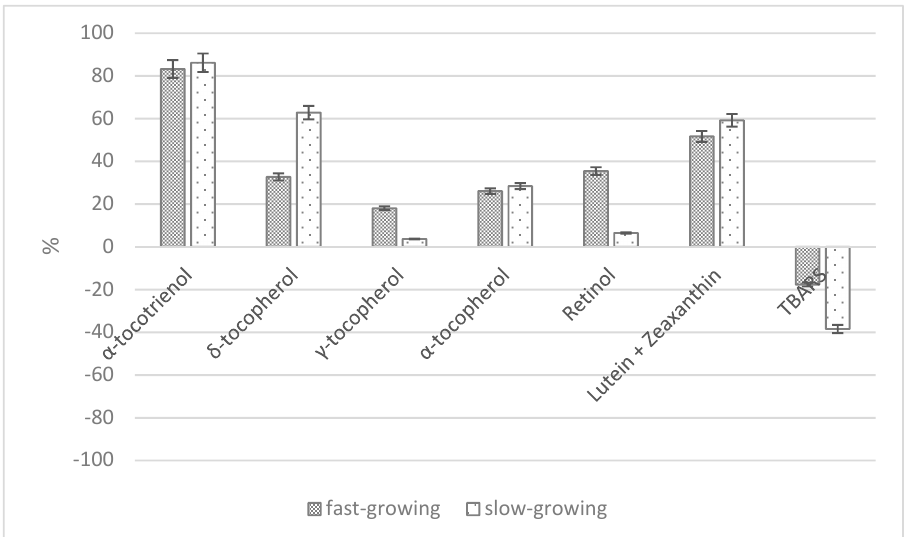
Figure 4. Variation (% with respect to no transport) of antioxidants ( α -tocotrienol, α -, γ -, δ -tocopherol, retinol and carotenoids) and TBARS in fast- and slow-growing chicken strains after 4 h of transport (modified by [51]).